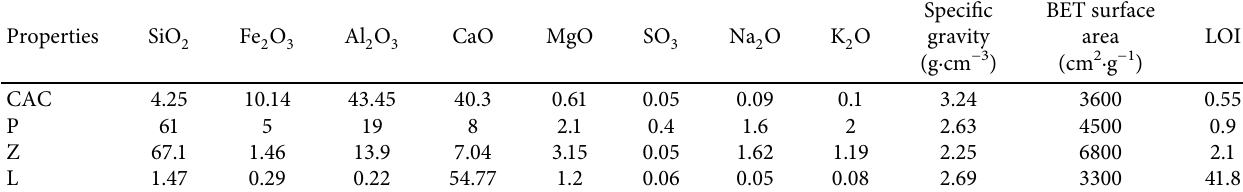
Table 1: Physical properties and chemical composition of the cement, pumice, zeolite, and limestone.